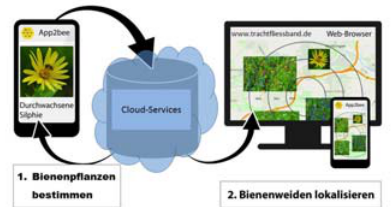
Figure 1: Basic design of the Beesmart crowdsourcing application to determine bee flowers and to localize nutrition areas (Source: Bernhard & Boris